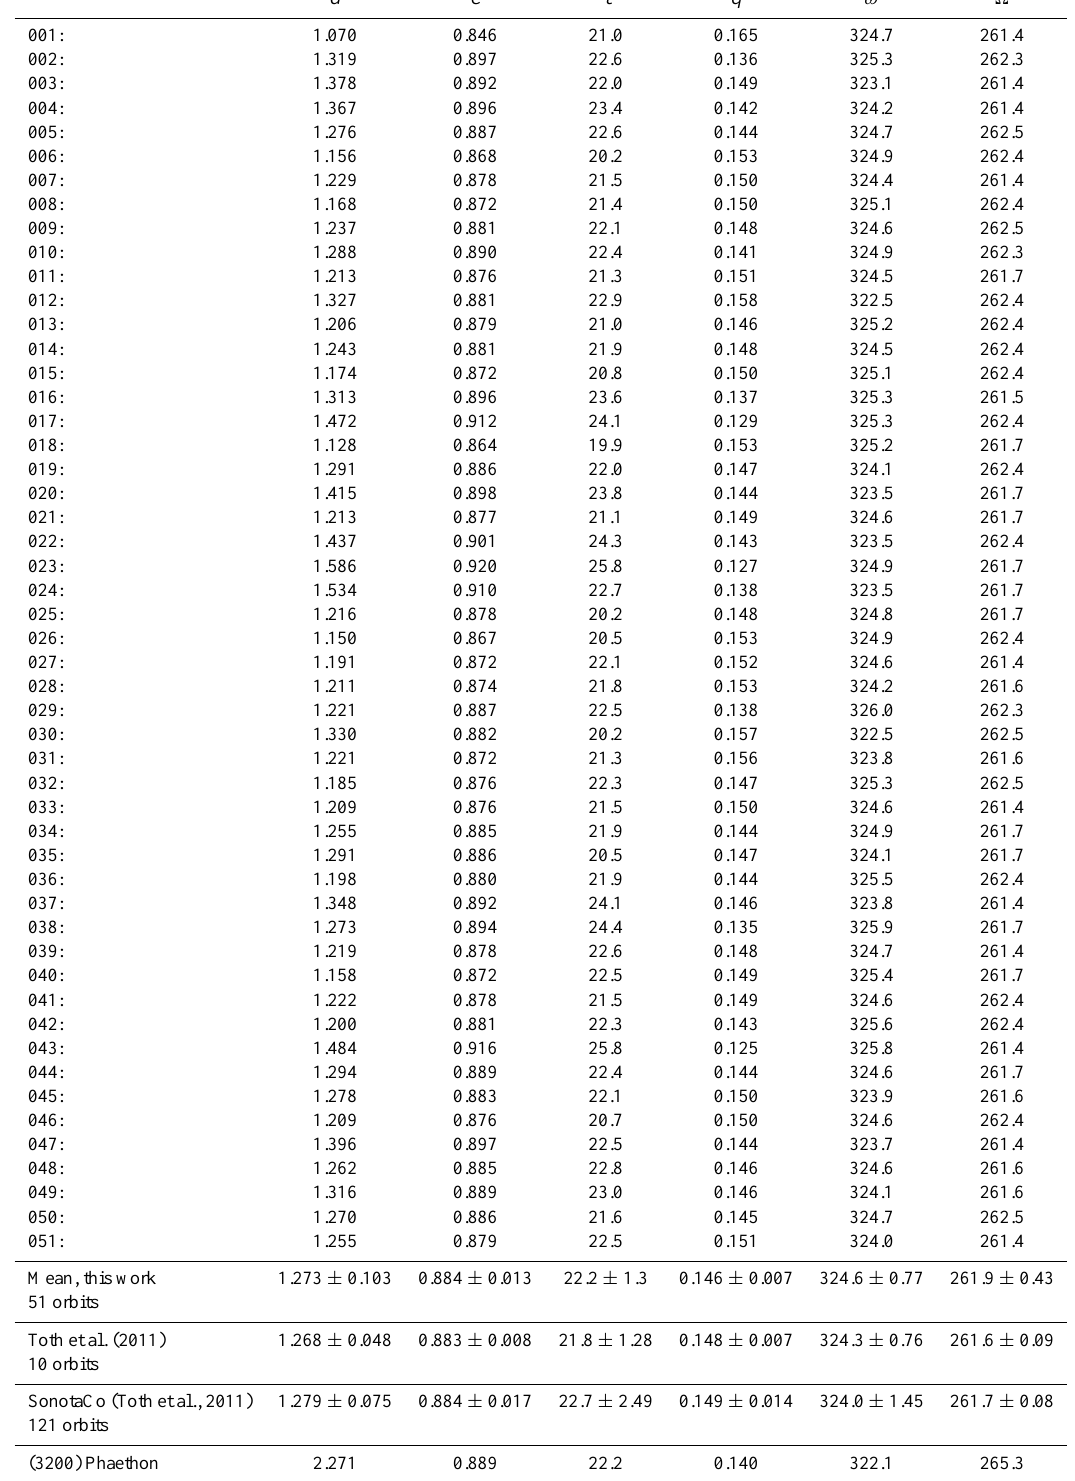
Table 4. Orbits of the 51 Geminid meteors as obtained by the CILBO system in the nights 13–15 December 2011. The average values are compared to other authors and the orbital elements of the parent body (3200) Phaethon. a : semi-major axis in AU; e : eccentricity; i : inclination in degrees; q : pericentre distance in AU; ω : argument of pericentre in degrees; (cid:127) : longitude of ascending node in degrees.